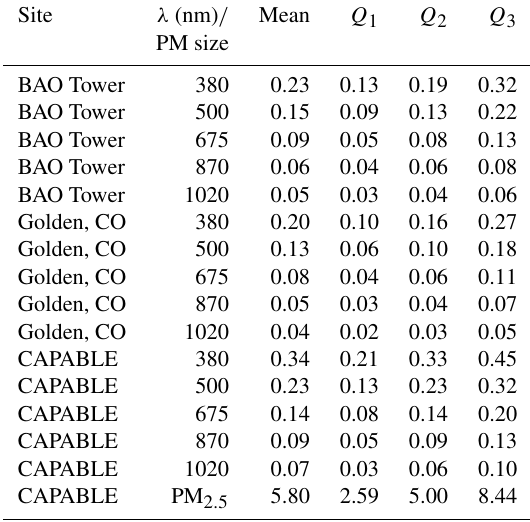
Table 1. Aerosol optical thickness statistics at the three sites under study. Here, Q 1 , Q 2 , and Q 3 represent the 25th, 50th, and 75th percentiles. Data have been filtered to show only data collected during the DISCOVER-AQ 2014 field campaign period (July– August